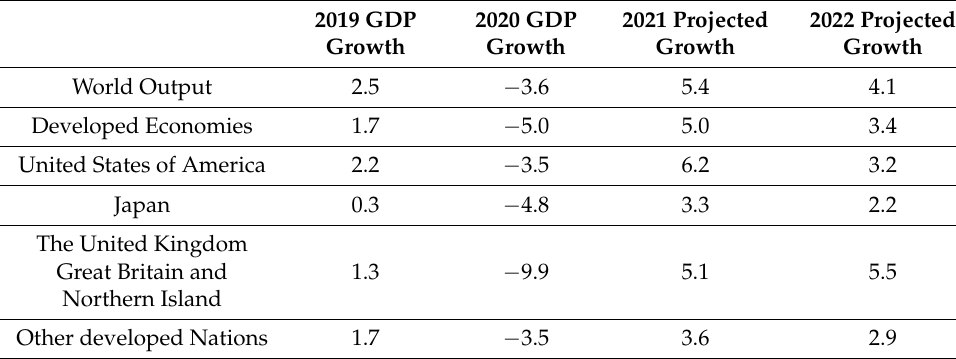
Table 2. Growth of world output and Developed